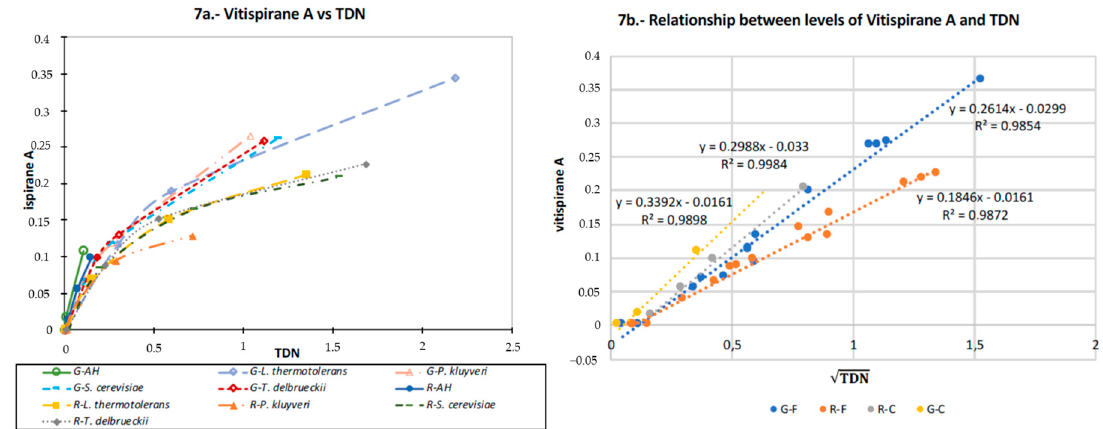
Figure 7. ( a ) TDN relative areas versus those of vitispirane A for all fermented samples and unfermented controls (AH) for the Garnacha (G) and Riesling (R) samples. The samples from the same condition (variety x yeast) aged at di ff erent times are represented with the same code and joined by a line. In all cases, the aged samples had increased levels of both compounds. ( b ) Levels of vitispirane A versus the square root of the TDN levels. The samples were classified into four categories: unfermented controls with Garnacha precursors (G-C); unfermented controls with Riesling precursors (R-C); fermented samples spiked with Garnacha precursors (G-F); and fermented samples with Riesling precursors (R-F). Microorganisms 2019 , 7 , x FOR PEER REVIEW The plot demonstrates the existence of a linear relationship within each category.